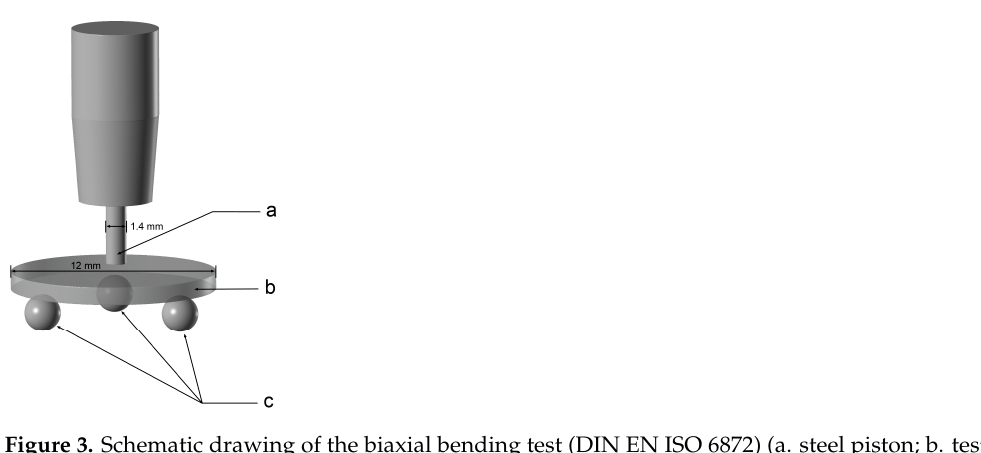
Figure 3. Schematic drawing of the biaxial bending test (DIN EN ISO 6872) (a. steel piston; b. test specimen; c. supporting spheres placed in a circular manner at 120° from each other).